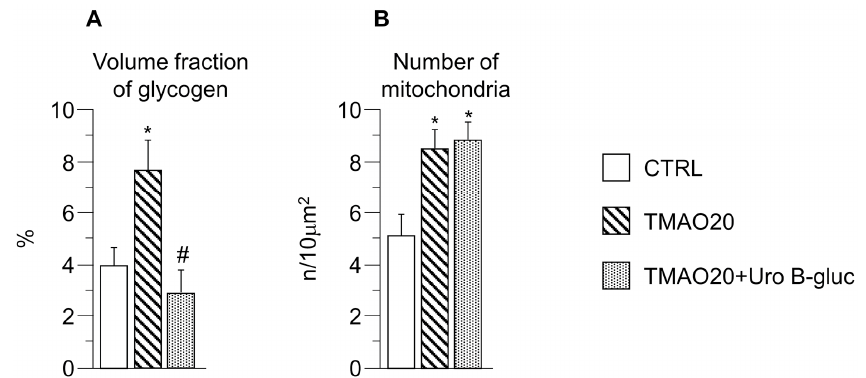
Figure 4. Effects of TMAO and TMAO + Uro B-gluc on cardiomyocyte glycogen content and mitochondria. Mean values ± SEM of the volume fraction of glycogen ( A , %) and the number of mitochondria ( B , n/10 µm 2 ) in CTRL, TMAO20, and TMAO20 + Uro B-gluc cells. * p < 0.05 significant differences vs. CTRL; # p < 0.05 significant differences vs. TMAO20 (non-parametric statistical test: Kruskal Wallis and U-Mann Whitney test).